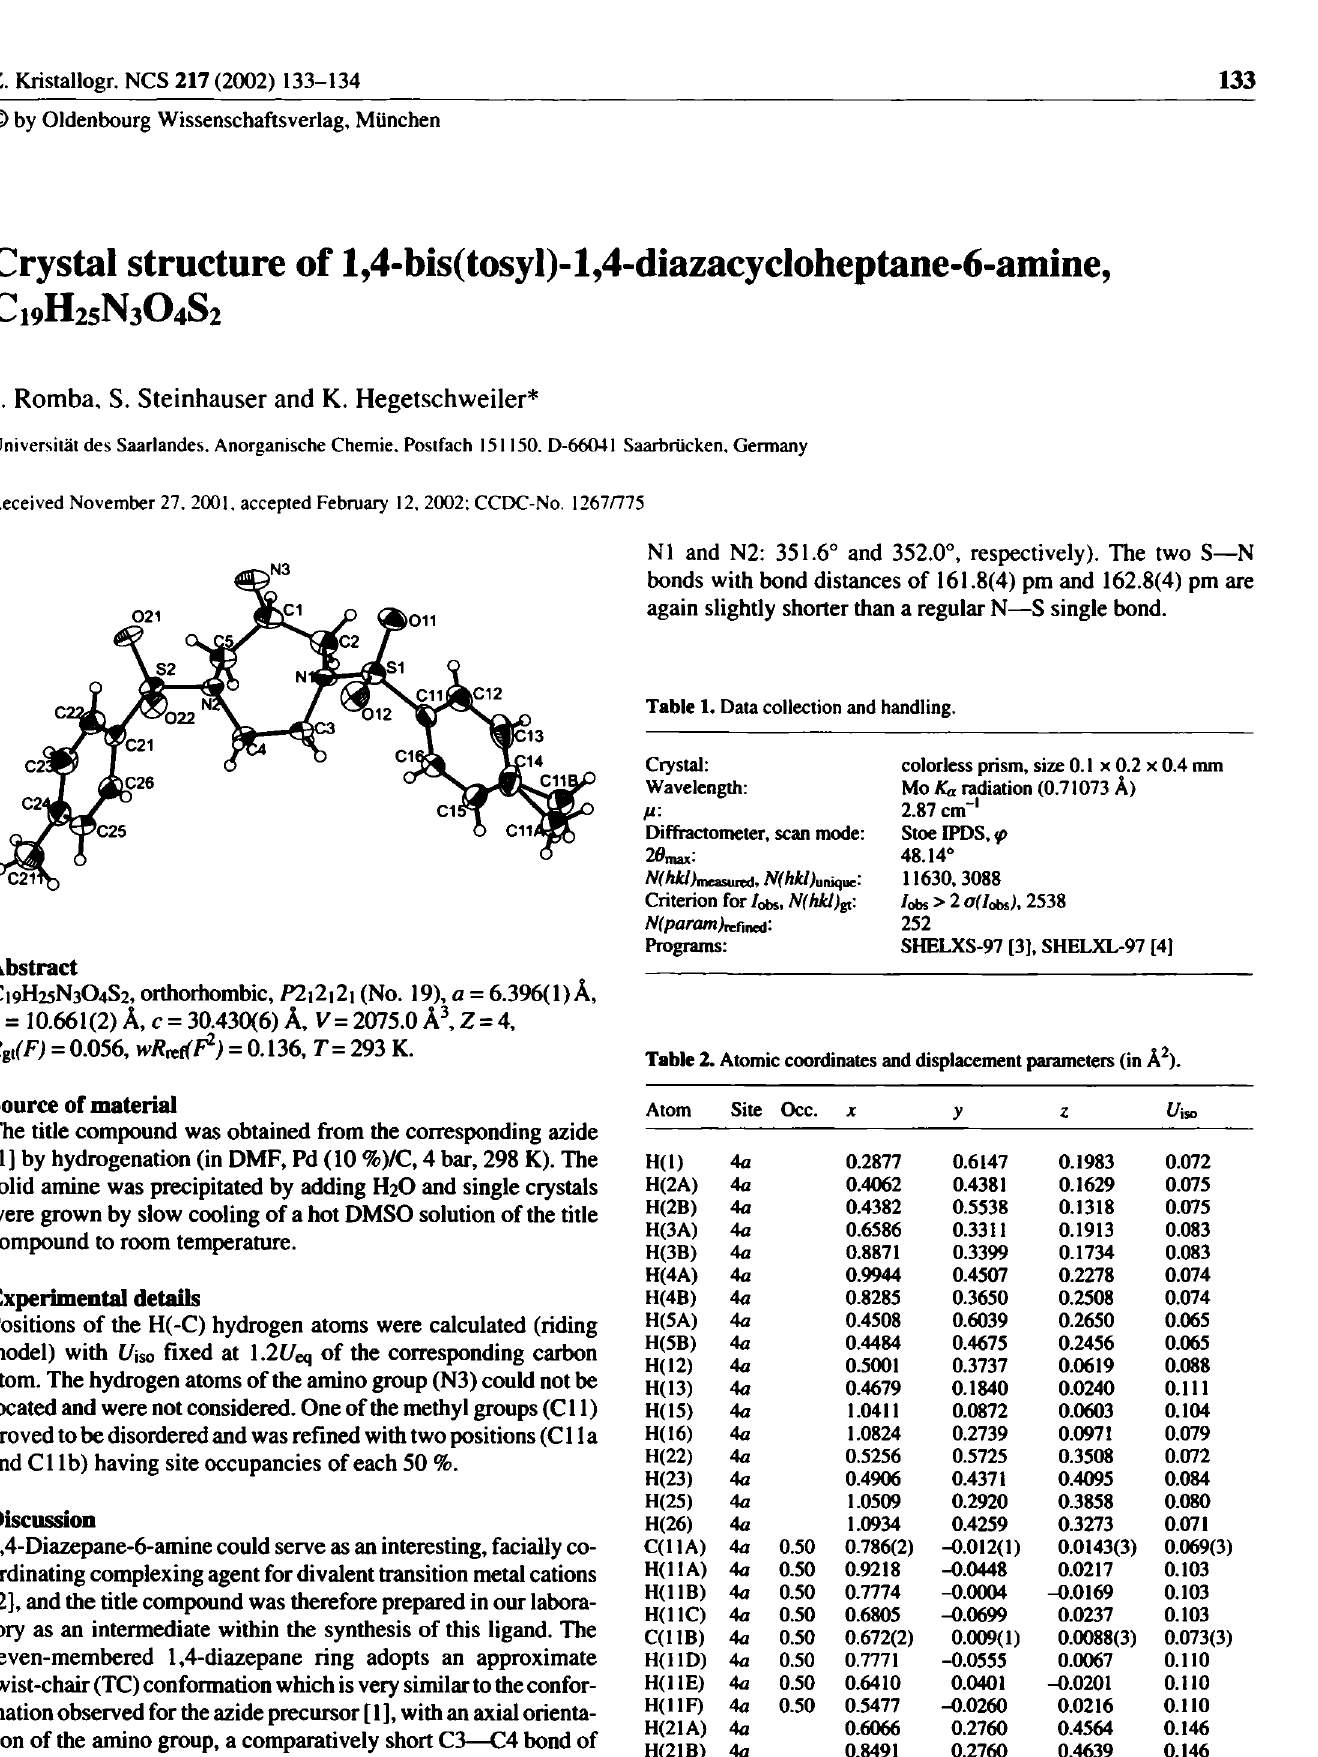
Table 2. Atomic coordinates and displacement parameters (in Â 2